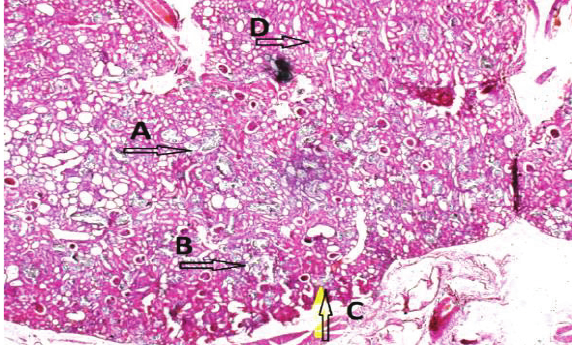
Fig-2A: Rat kidney (group 2) showing crystals of calcium oxalate and uric acid under 4x A, B. Tubules with accu- mulated crystals C, D. Damaged epithelium of tubule Table-1: All values are stated as mean±SEM of 6 rats(n=10) #p<0.001 when compared to negative control